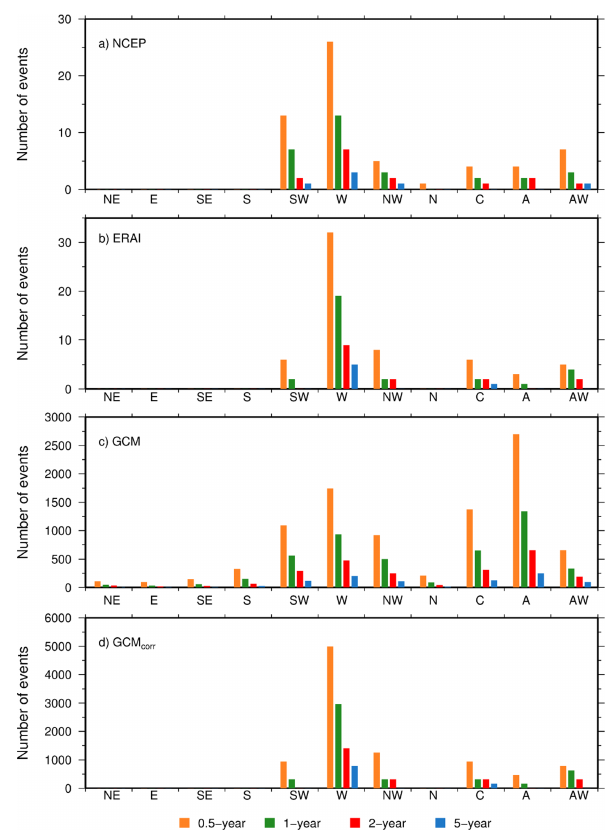
Figure 4. (a) Distribution of events exceeding a certain return level depending on the CWT for LI NCEP. Colours denotes the differ- ent return level (0.5-, 1-, 2- and 5-year events); (b) same as (a) but for ERAI; (c) same as (a) but for the GCM ensemble; (d) same as (c) but for the corrected frequency of events per weather type based on ERAI. For (a) and (b) the total number of years is 30, for (c) and (d) it is 4092